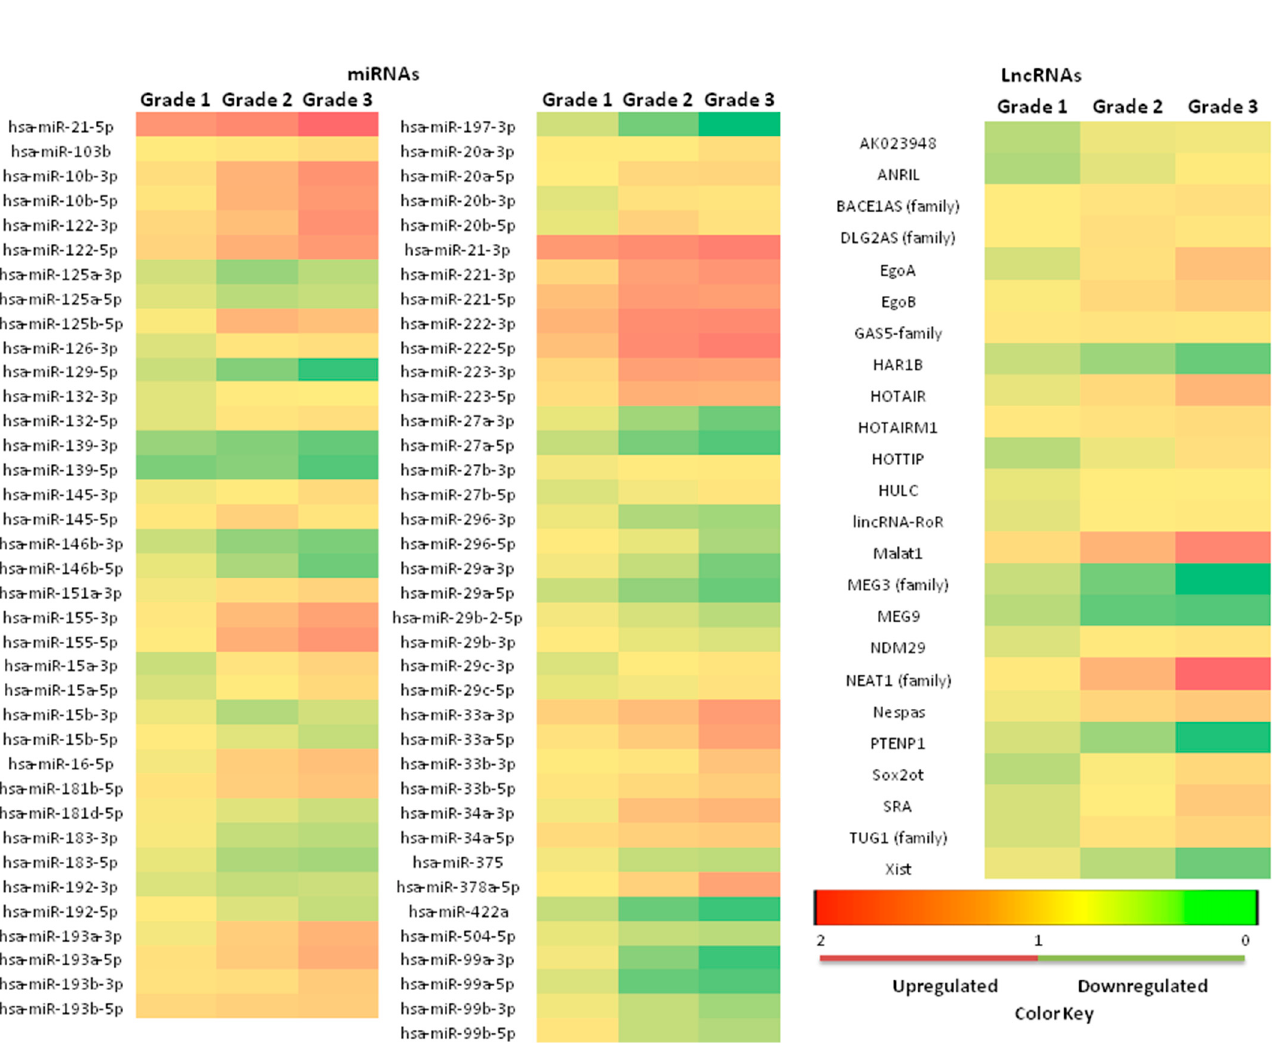
Figure 1. Heatmap of statistically significant miRNA and lncRNA expression profiles detected by qPCR in NAFLD patients compared to the healthy controls.